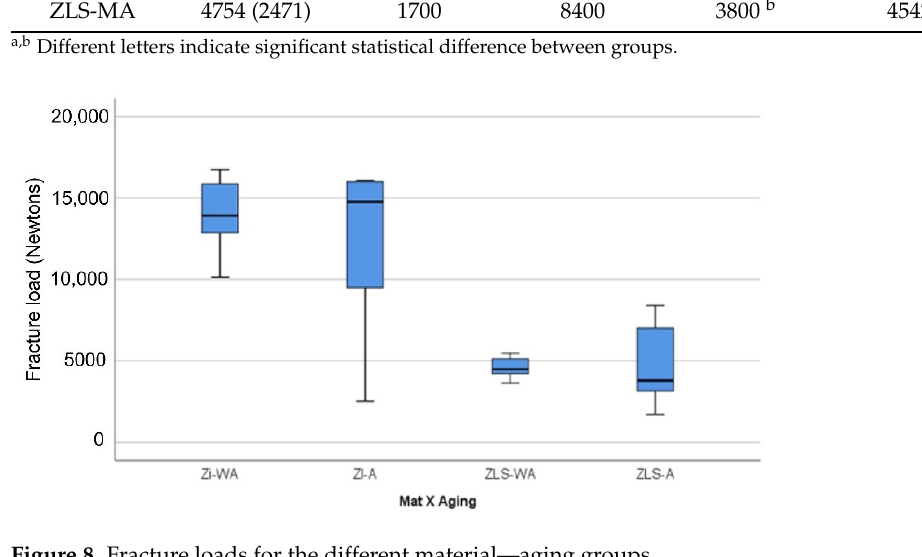
Figure 8. Fracture loads for the different material—aging groups. Table 5. Zi and ZLS loaded crown failure types.